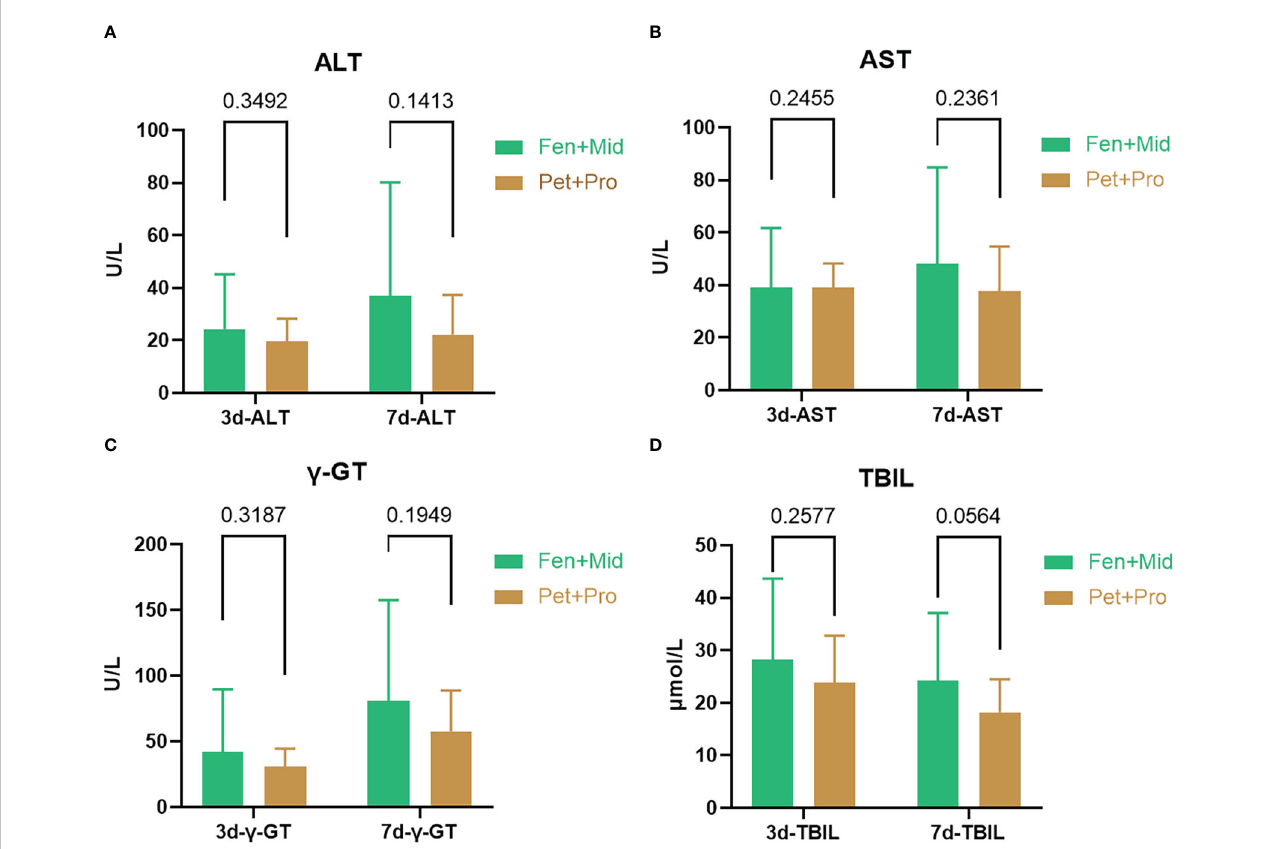
FIGURE 1 Promethazine + pethidine is associated with less liver injury than fentanyl + midazolam in patients after severe burns. The patients were divided into two groups according to the treatments they received: the Fen+Mid group (fentanyl + midazolam, n = 30) and the Pet+Pro group (pethidine + promethazine, n=21). The plasma levels of alanine aminotransferase (ALT, (A) ), aspartate aminotransferase (AST, (B) ), g -Glutamine transferase ( g -GT, (C) ), and total bilirubin (TBIL, (D) ) on the three or seven days after patient ’ s admission were obtained from the patient ’ s medical